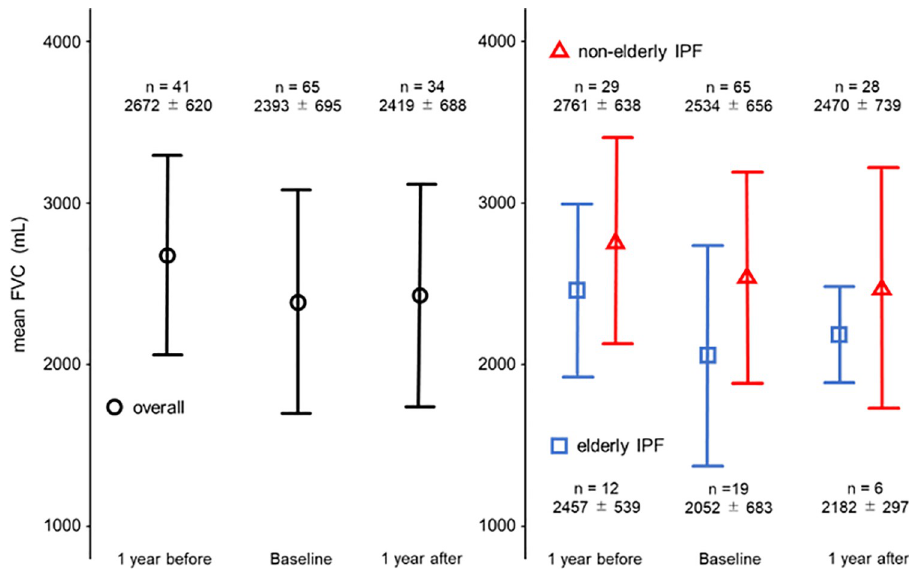
Fig 1. The mean FVC of IPF patients treated with nintedanib. Changes in mean FVC ( ± SD) at 1 year before, at baseline, and at 1 year after nintedanib initiation for IPF patients. There was a reduction of FVC decline after nintedanib initiation in all groups. (Black: overall group, blue: elderly IPF group, red: non-elderly IPF group). Abbreviations: FVC: forced vital capacity, IPF: idiopathic pulmonary fibrosis, SD: standard deviation.